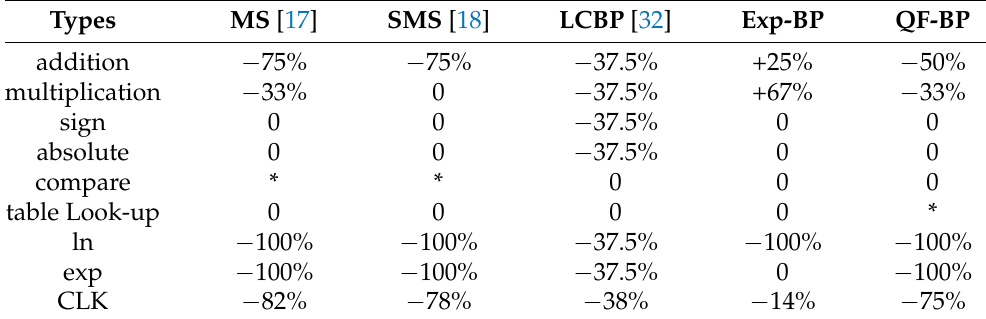
Table 6. The percentage of decline in different operations of different algorithms compared with the BP